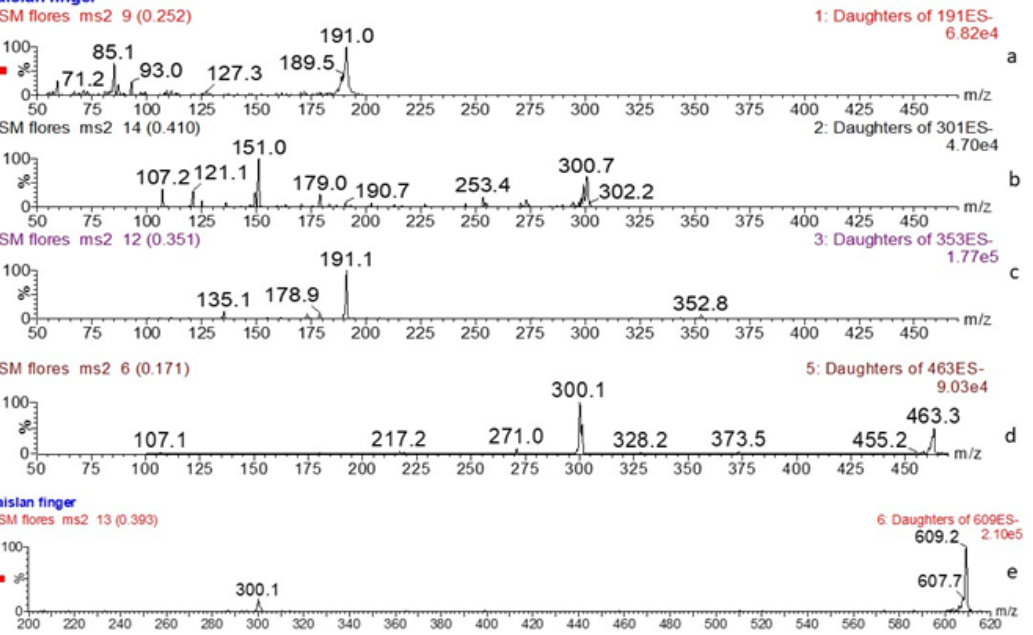
Figure 3. ESI(-)-MS/MS spectra of the compounds quinic acid (a), quercetin (b), chlorogenic acid (c), hyperoside (d) and rutin